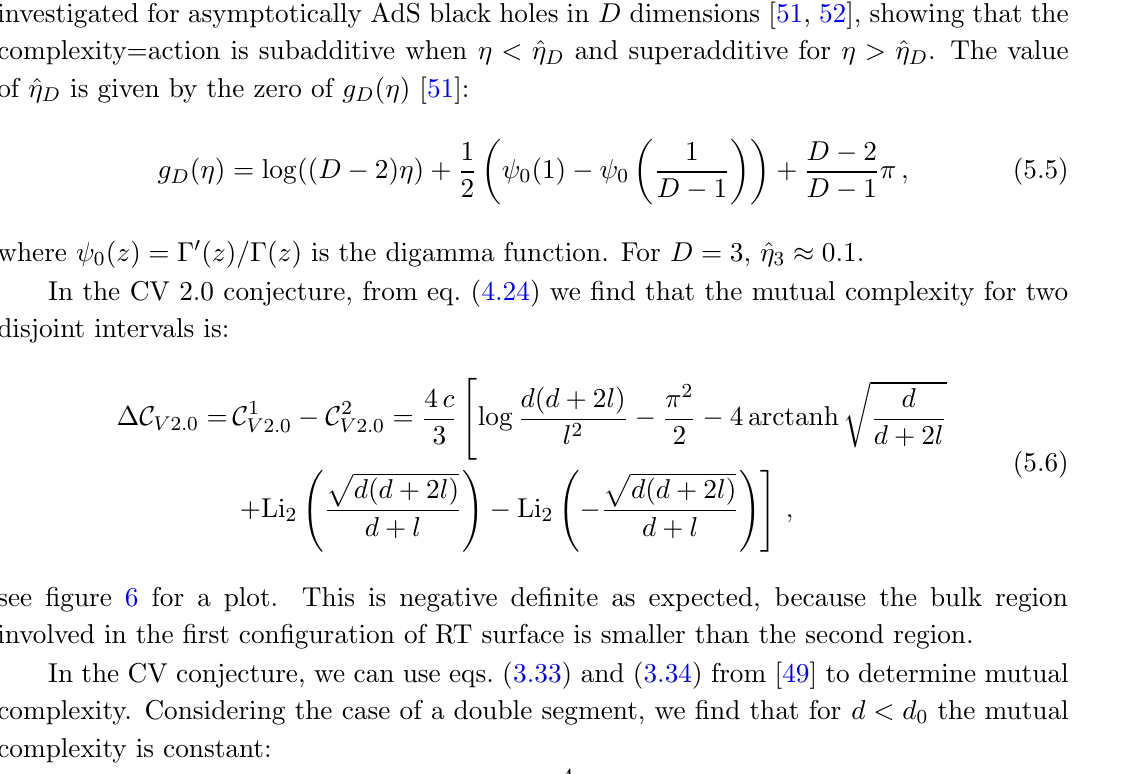
Figure 6 . Left: mutual complexity (cid:1) C A for several values of (cid:17) = ~ L=L as a function of d p 2 (cid:0) 1]. In order to have a positive-de(cid:12)nite complexity, we must impose (cid:17) > 1. The other values of (cid:17) have been included for illustrative purpose. Right: mutual complexity (cid:1) C V 2 : 0 . Here we set c =